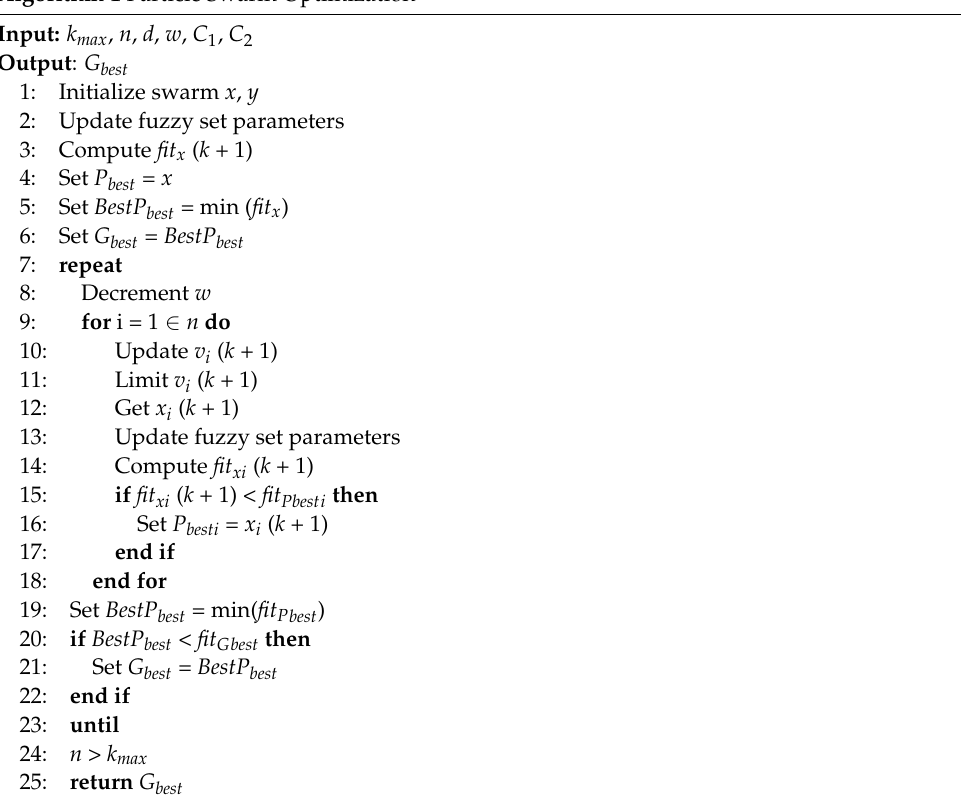
Algorithm 1 Particle Swarm